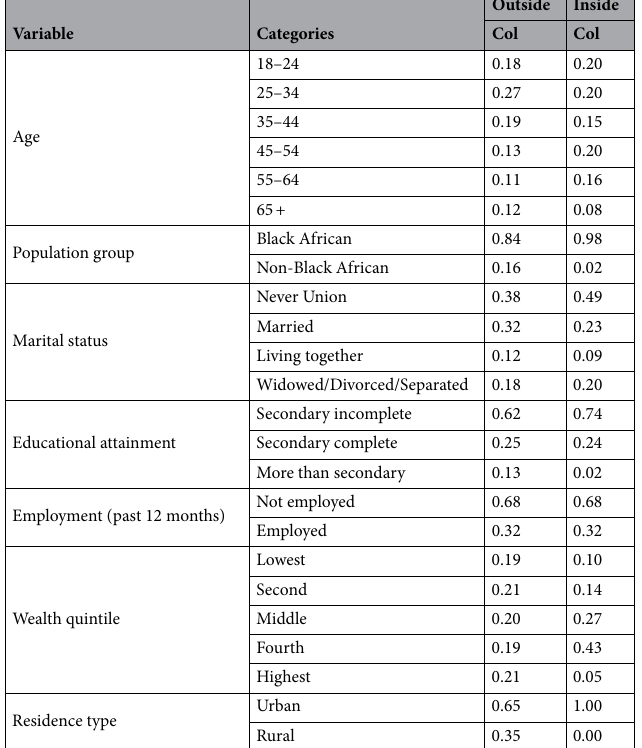
Table 2. Sociodemographic characteristics and correlates of living inside/outside physical IPV syndemic area based on bivariate analyses (N = 5932). Relative frequency within column that adds up to 1 (or 100%). Bolded means p < 0.05 based on the Pearson chi-squared statistic is corrected for the survey design with the second- order correction of Rao and Scott 44 and is converted into an F statistic.